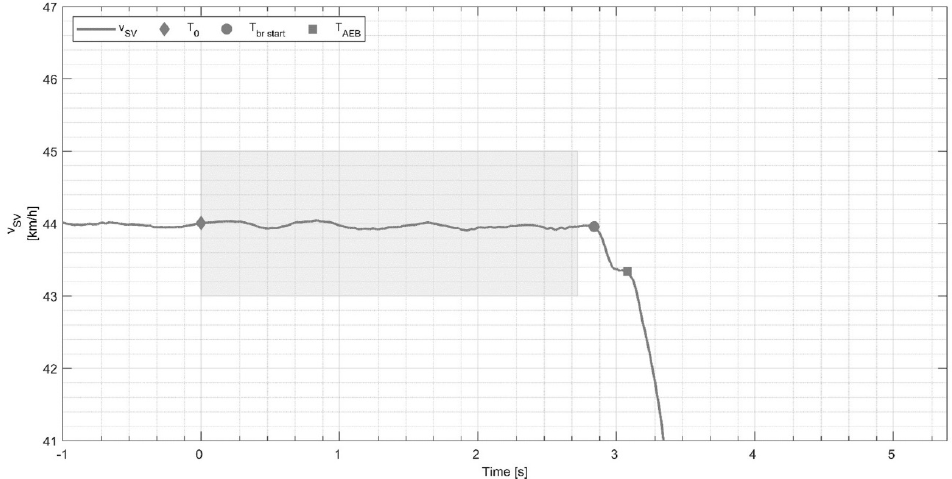
Figure 25. SV velocity